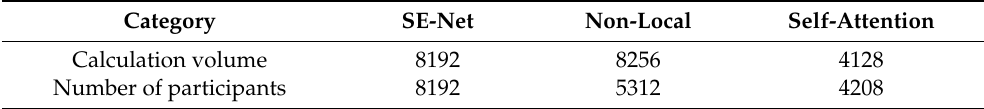
Table 2. Comparison of the calculation amount and parameter amount between the self-attention module and the typical attention modules. The input data dimension is 16 * 128 * 4 * 1 (B × C × W × H), and the parameter amount and calculation amount of the three attention modules are calculated, respectively (r in Figure 4a is taken as 4).